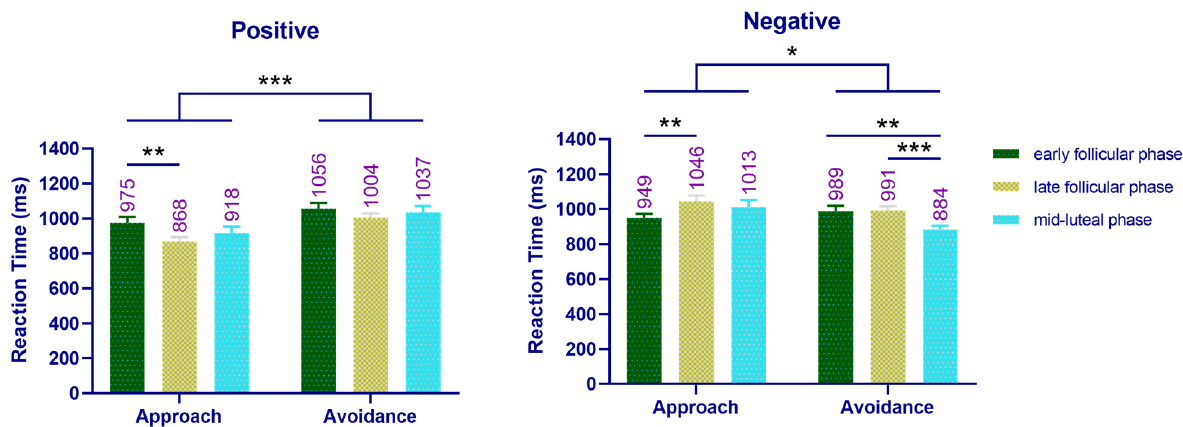
Figure 4. Reaction time of the improved “manikin task” across the cycle phases in Experiment 1. Left: the reaction time of women performing approach–avoidance behavior to a positive emotional picture across the cycle phases. Right: the reaction time of women performing approach–avoidance behavior to a negative emotional picture across the cycle phases. Mean RT above bar. Error bars represent the standard error of the mean. *** p < 0.001; ** p < 0.01; * p < 0.05.